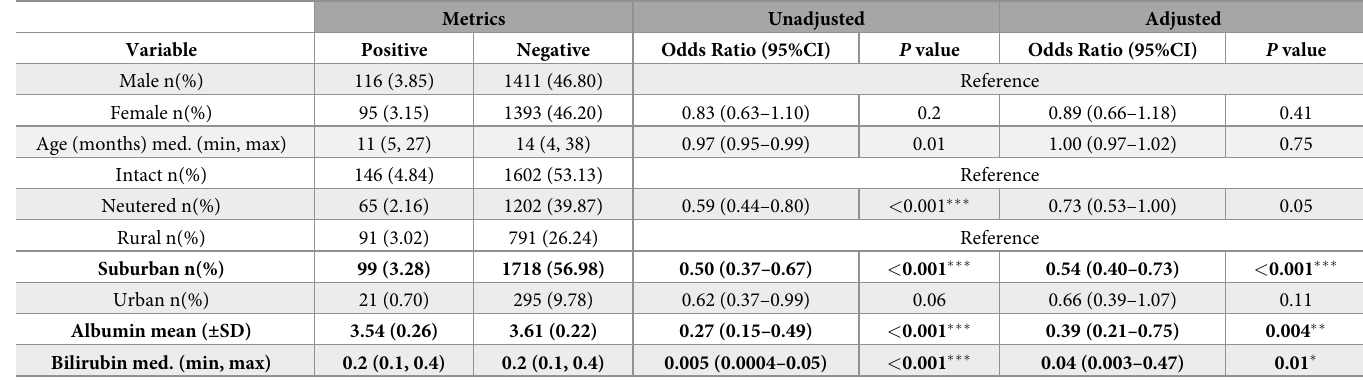
Table 2. Adjusted and unadjusted odds ratios and confidence intervals for the chemistry model. Bolded parameters remained significant in the adjusted model. Metrics